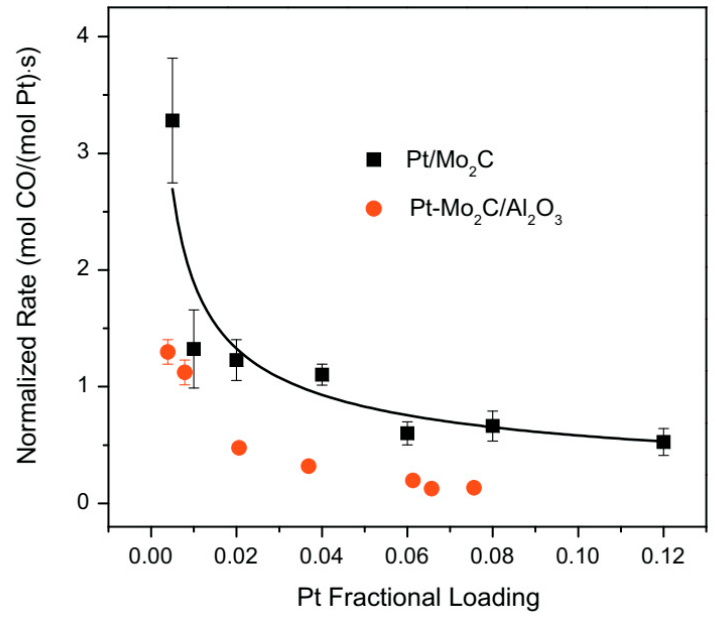
Figure 10. Dependence of platinum normalized water–gas shift rates on the Pt loading for Pt/Mo 2 C and Pt-Mo 2 C/Al 2 O 3 adapted from [78], with permission from Elsevier, 2013; P = 1 atm, T = 240 °C, 11% CO, 43% H 2 , 6% CO 2 , 21% H 2 O, 19%N 2 , WHSV = 70 h −